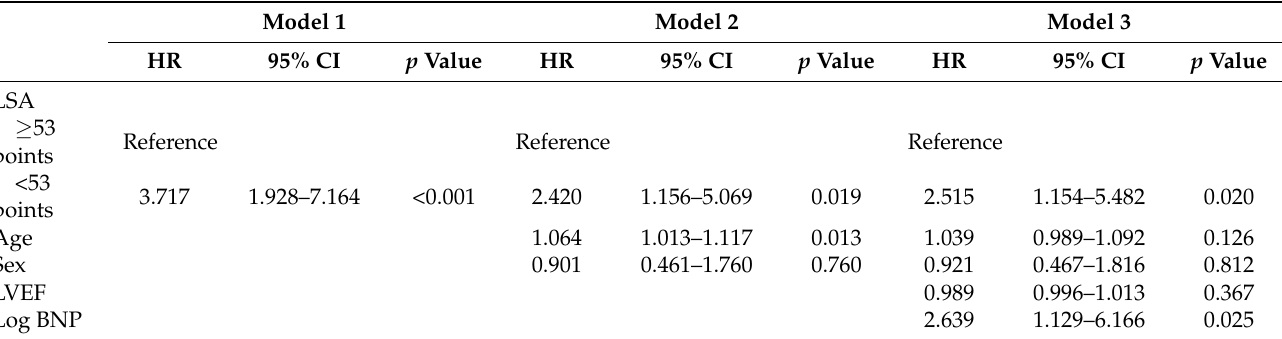
Table 3. Cox proportional hazards analysis (cardiovascular hospitalization).